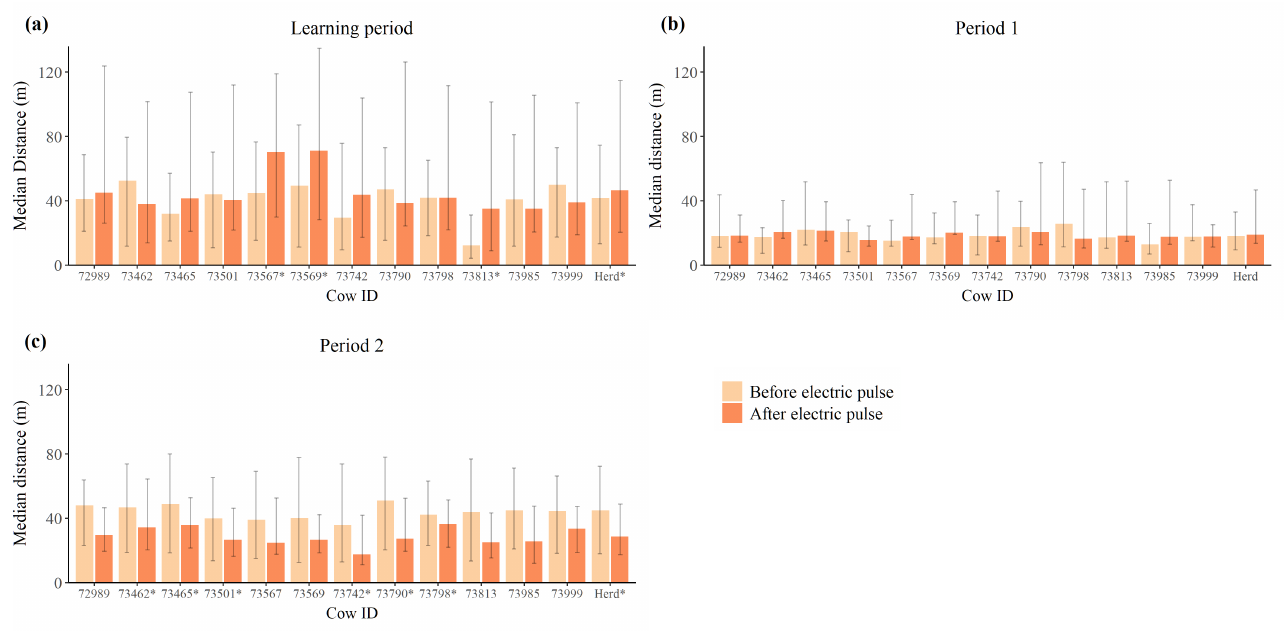
Figure 5. Median distance to the virtual border of each individual cow and the herd collectively, be- fore and after any one individual received an electric impulse during ( a ) the learning period ( n = 3077), ( b ) period 1 ( n = 402), and ( c ) period 2 ( n = 4831). Error bars represent the interquartile range. An asterisk next to the serial number denotes statistical significance ( p < 0.05).